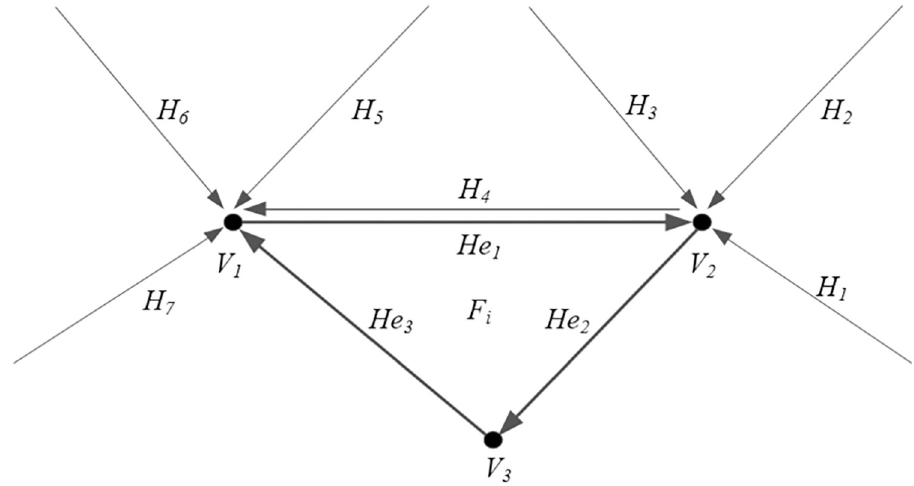
Fig 6. Diagram of half-edge